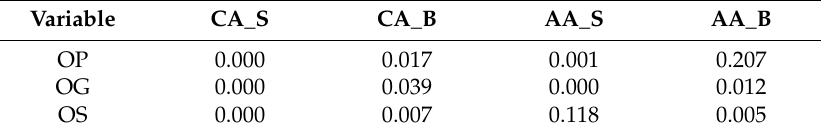
Table 12. Standardized total effects—two tailed significance (BC).